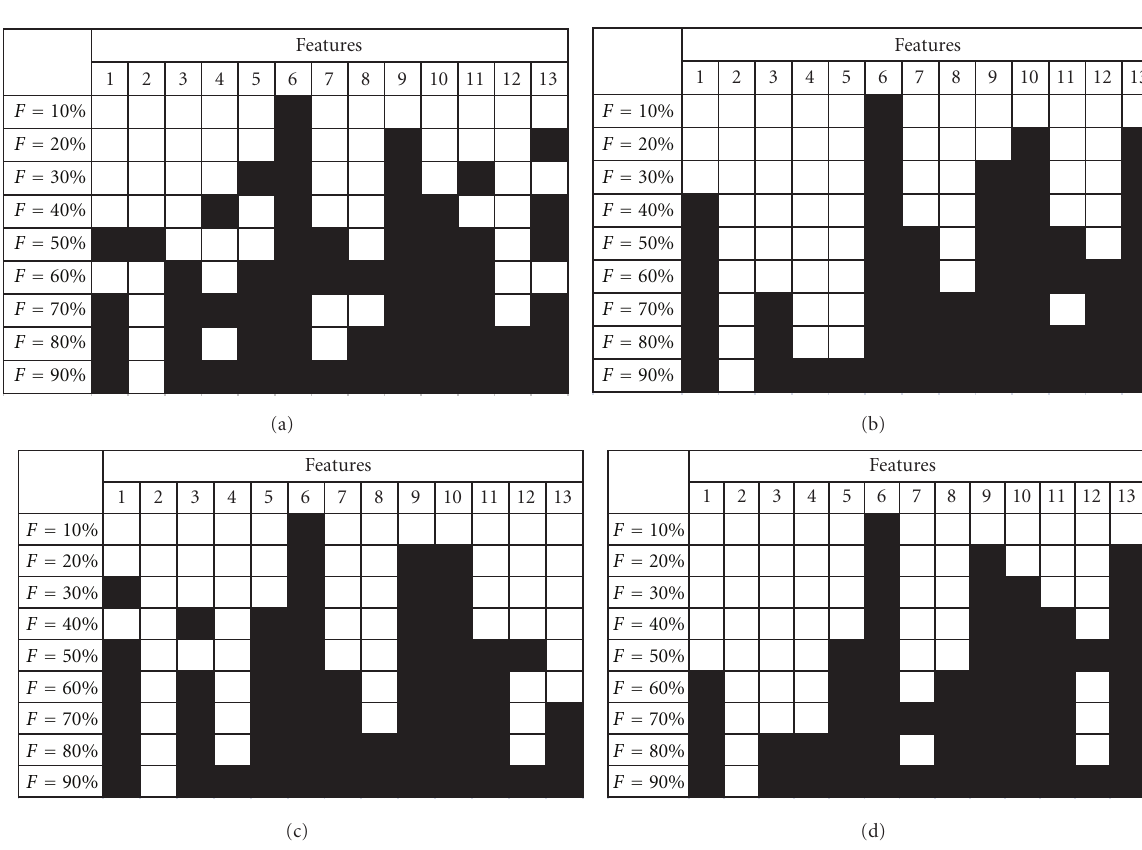
Figure 12: Comparison of sets of features being selected by using PSO and CPSO 2 for Housing data dataset: (a) PSO method with 30% of selected data, (b) CPSO 2 method with 30% of selected data, (c) PSO method with 70% of selected data, and (d) CPSO 2 method with 70% of selected data.